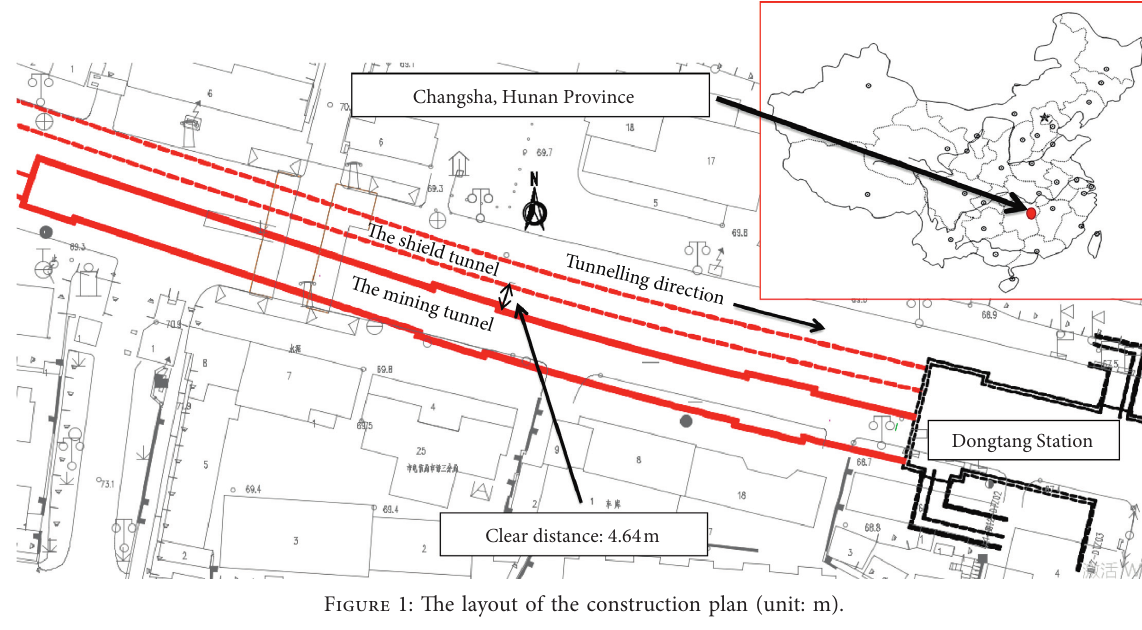
Figure 1: The layout of the construction plan (unit: m).